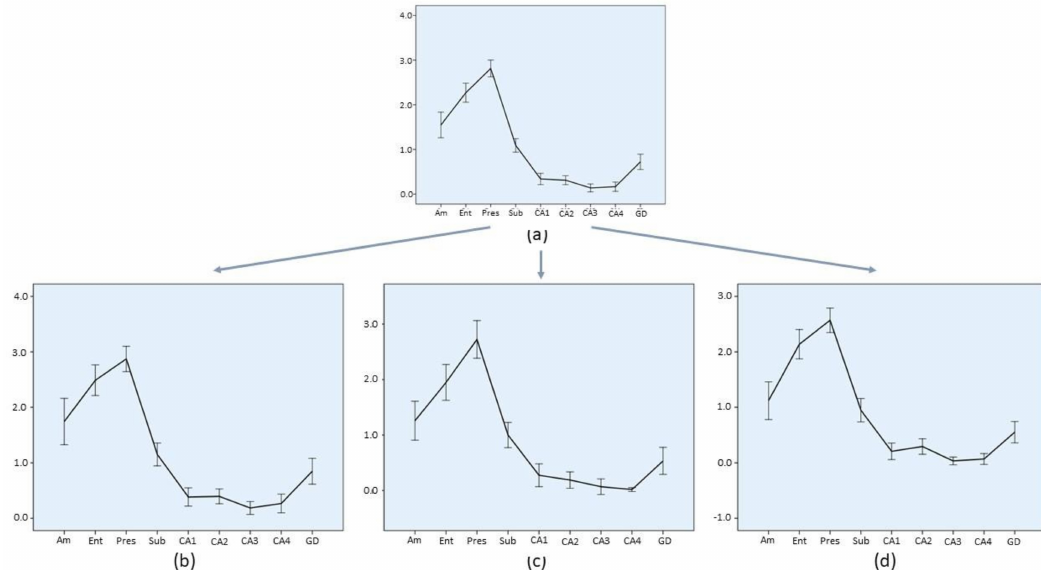
Figure 4. Regional profile of average involvement (Ai) intensity along the medial temporal lobe of sCJD histotype groups. Slight diversity of profiles within the sCJD MM/MV1 subtype is shown. Confidence interval bars (95%) are shown as all groups include n > 30. Note the different scale range of single charts. ( a ) All sCJD MM/MV1 cases, either pure or mixed, as shown in Figure 3a. ( b ) Only pure sCJD MM/MV1 cases with PrP res type 1; ( c ) mixed sCJD MM/MV (1 + 2) cases; and ( d ) pure sCJD MM/MV1 cases excluding cases with atypical phenotype. Am : amygdala; Ent : entorhinal cortex; Pres : presubiculum; Sub : subiculum; CA1 , CA2 , CA3 and CA4 : CA Sommer’s sectors of the hippocampus; GD : dentate gyrus.